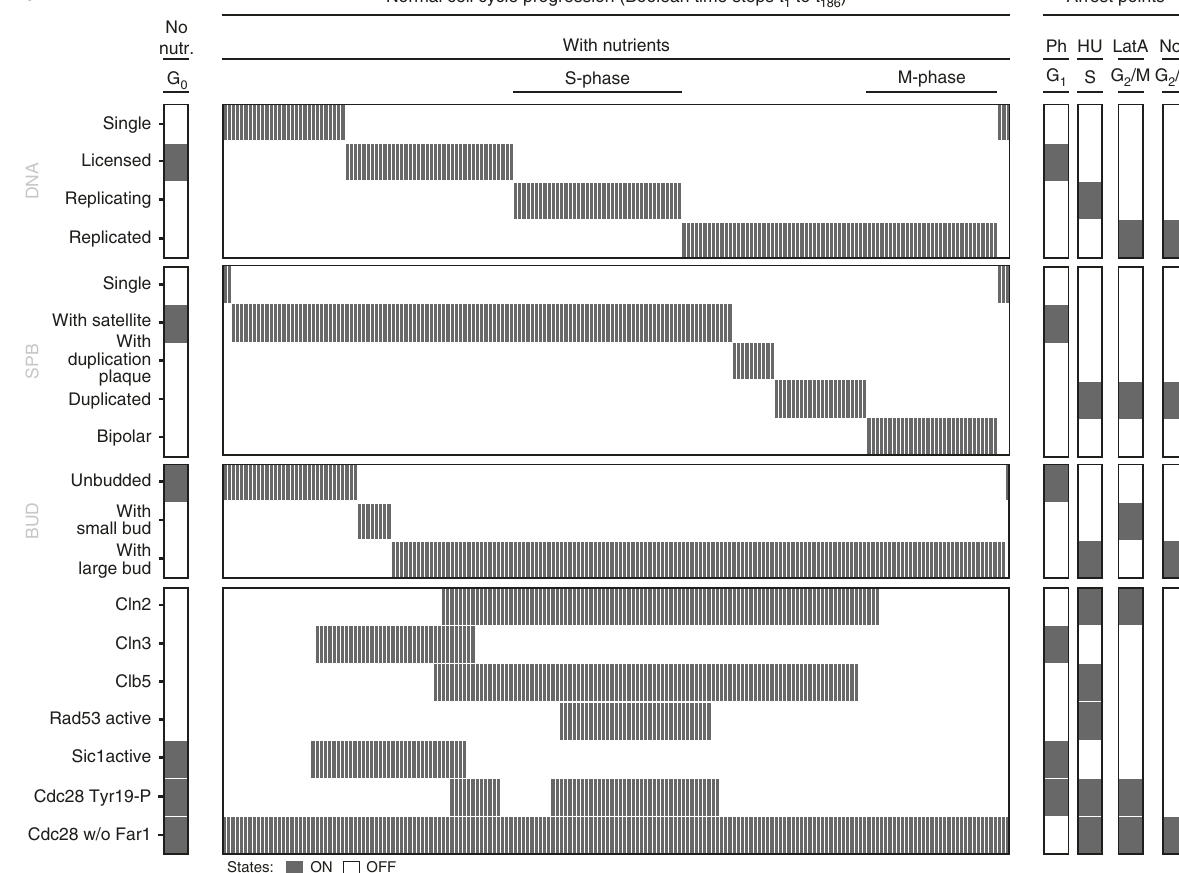
Fig. 4 The parameter-free model reproduces both cell-cycle progression and arrest. Simulation results visualised on the CGM states (Fig. 2c), the cyclins Cln3, Cln2 and Clb5, the active form of the CDKI Sic1, and three selected elemental states: active Rad53 (indicative of ongoing DNA replication), Tyr19 phosphorylated Cdc28 (inhibition of Cdc28 – Clb1/2) and Cdc28 not bound to Far1 (disappears during pheromone arrest). a When the model is simulated with nutrients set to false, the cells arrest at G 0 : with licensed DNA, SPB-satellite, without bud and without cyclin or Rad53 activity. b When cells are released from the G 0 arrest by setting nutrients to True, they progress through the cell division cycle by replicating their DNA, undergoing nuclear division and rapidly thereafter cell division, and resetting the network for a new division, traversing 186 Boolean steps. Cyclin activities rise and fall through cyclin expression and inhibition by Sic1 and Swe1 (Tyr19 kinase). c The cells arrest again when exposed to pheromone (G 1 : licensed DNA, SPB-satellite, no bud, only Cln3 present), HU (S: replicating DNA, duplicated SPB, large bud, Cdc28-Cln2, Cdc28-Clb5 and Rad53 are active), LatA (G 2 /M: replicated DNA, duplicated SPB, small bud, only Cdc28-Cln2 active) and NOC (G 2 /M: replicated DNA, duplicated SPB, large bud, and high Cdc28-Clb2 activity (not